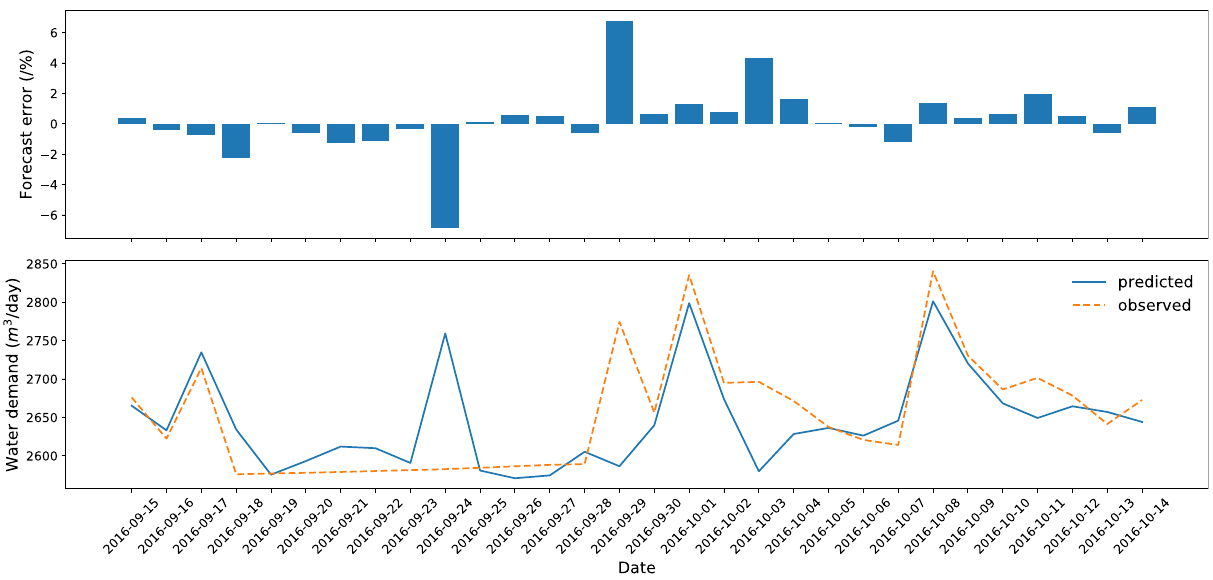
Figure 3. Research results for the best variant of forecasting—test dataset (dataset no.